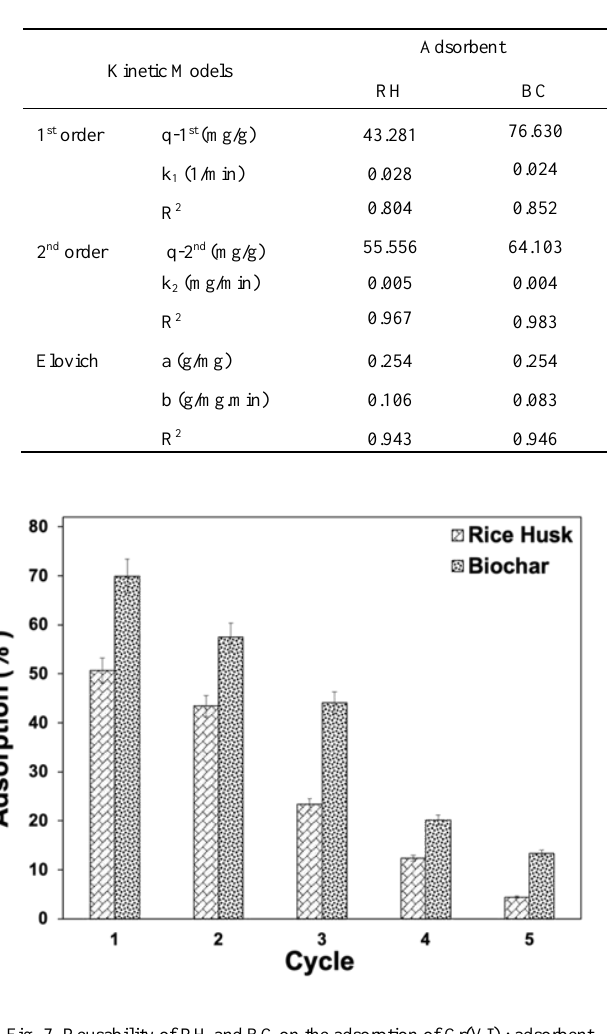
Fig. 7. Reusability of RH and BC on the adsorption of Cr(VI) ; adsorbent dose = 0.5 g; volume adsorbate = 0.25 L; shaking time = 30 min; pH = 2-4; shaking speed = 180 rpm; initial concentration = 50 mg/L; temperature condition; 303